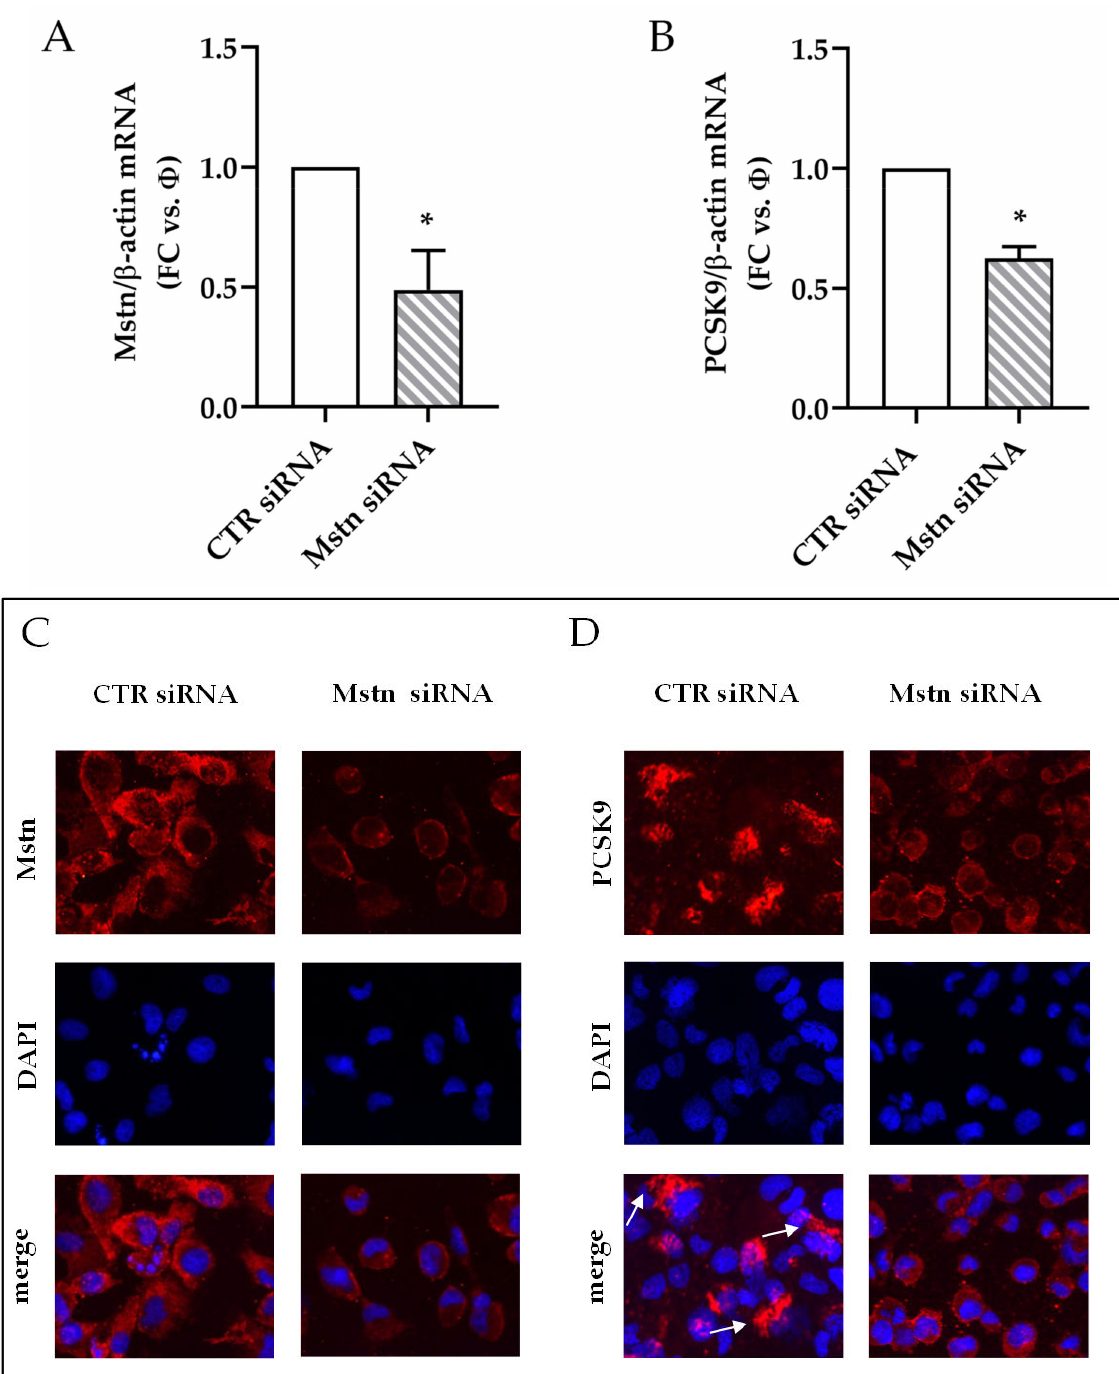
Figure 8. PCSK9 expression during I/R in Mstn-silenced HK-2 tubular renal cells. ( A ) Mstn and ( B ) PCSK9 mRNA levels in control siRNA cells (CTR siRNA) and Mstn siRNA cells after 3 h of ischemia. The results are obtained by quantitative real-time PCR, normalized expressing the number of transcript copies as a ratio to β -actin and indicated as fold changes (FC) in respect to CTR siRNA cells ( Φ ); * p < 0.05. ( C ) Mstn and ( D ) PCSK9 immunofluorescence (red signal, Alexa fluor 555) in control siRNA cells (CTR siRNA) and Mstn siRNA cells after 6 h of ischemia. White arrows indicate the cortical distribution of PCSK9 aggregates in CTR siRNA cells; magnification 40 ×